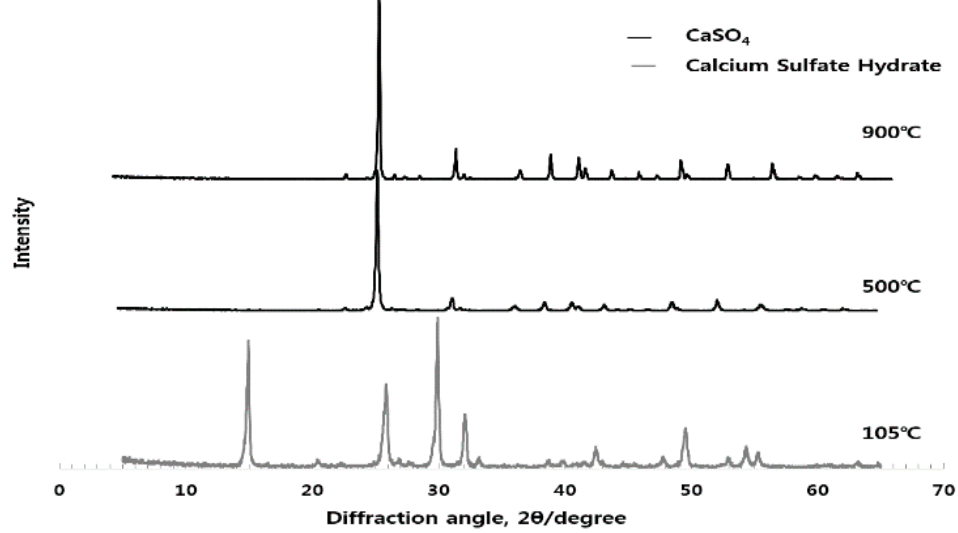
Figure 2. Quantitative analysis of the crystal structure of CG at different burning temperatures.